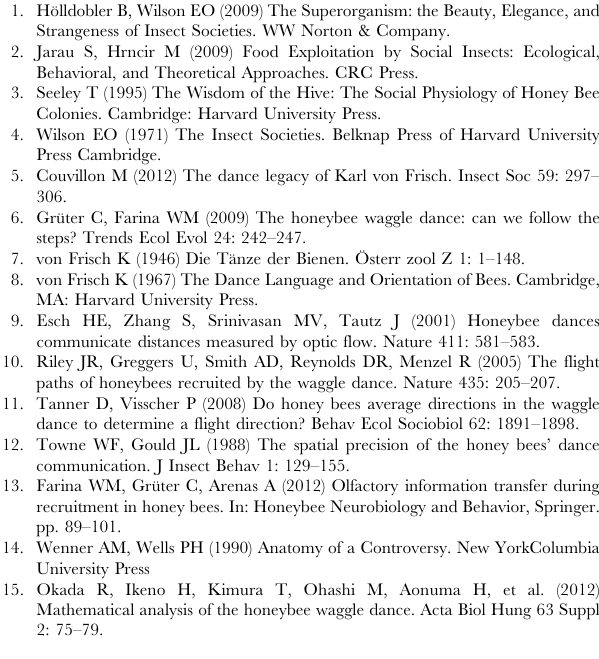
Figure S6 The effect of the exit probability p Exit on the foraging success measured as mean daily gain in honey (means 6 s.e.) with spatial information transfer (SI) or no spatial information transfer (NI). At all exit probabilites ( a) p Exit = 1; b) p Exit = 2; c) p Exit = 3; d) p Exit = 4) the switching between SI and NI treatments masks the benefit of SI (solid circle: SI, open circles: NI). Figure S7 A comparison of foraging success measured as mean daily gain in honey (means 6 s.e.) when recruits were switching food sources every day as opposed to visit food sources for multiple days (according to Fig. S1). Persistency allows the agents to gain long-term benefits from the spatial information transfer. (TIF) Text S1 The downloadable file, TextS1_BeeBenefitOfDance.n- logo, runs in NetLogo versions 4.1.3. NetLogo is freely available from the World Wide Web.